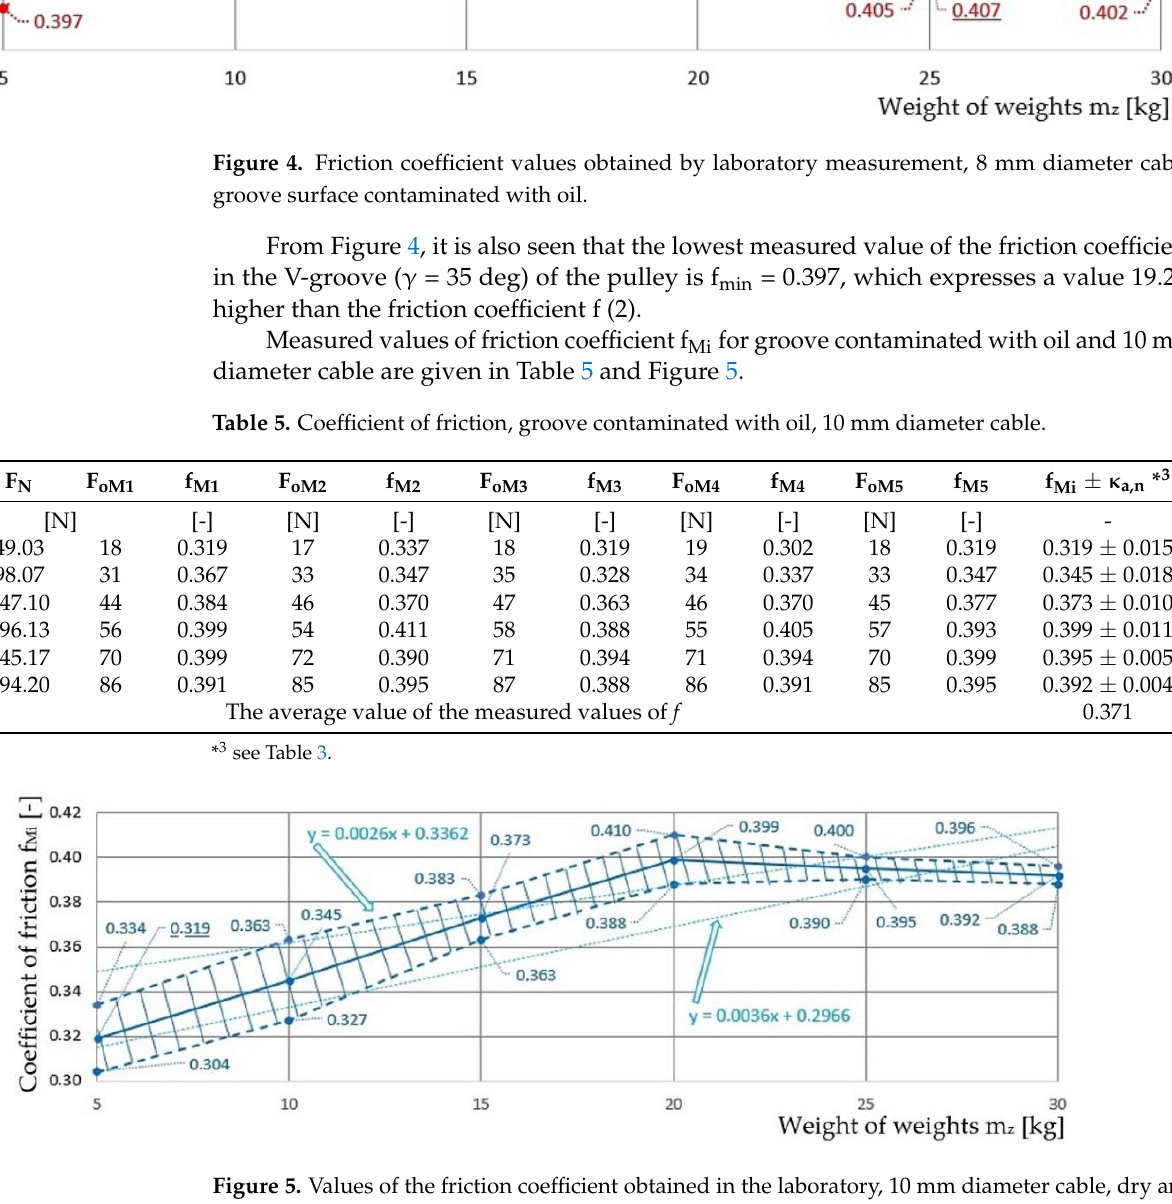
Table 6. Coefficient of friction, groove contaminated with oil, 8 mm diameter cable. m z